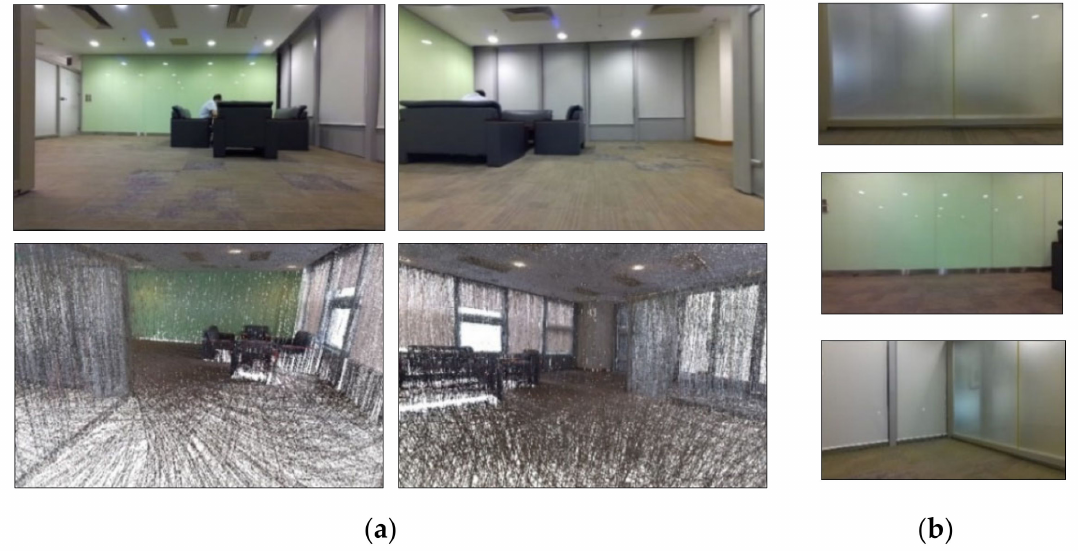
Figure 3. Low-texture setup. ( a ) The upper two images show the surveying room, and the lower two show the ground truth model using a Leica BLK360 imaging laser scanner. ( b ) Samples of the observed low-texture